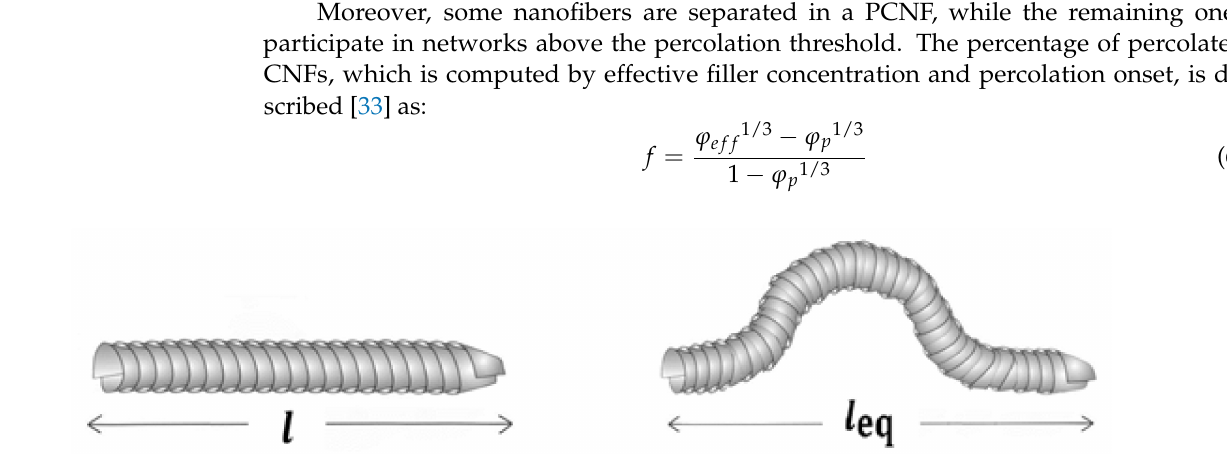
Figure 1. Straight and curved CNFs.